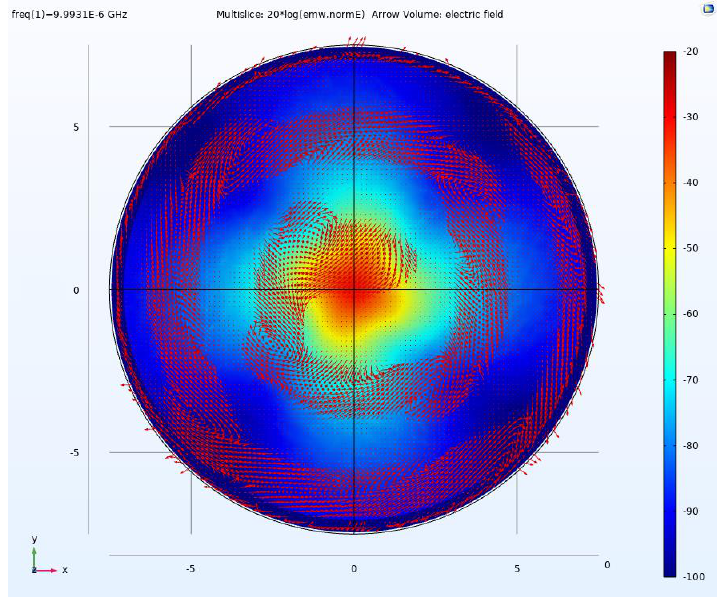
Figure 9. Electric field distribution and direction on the plane 10 km above the MD plane.